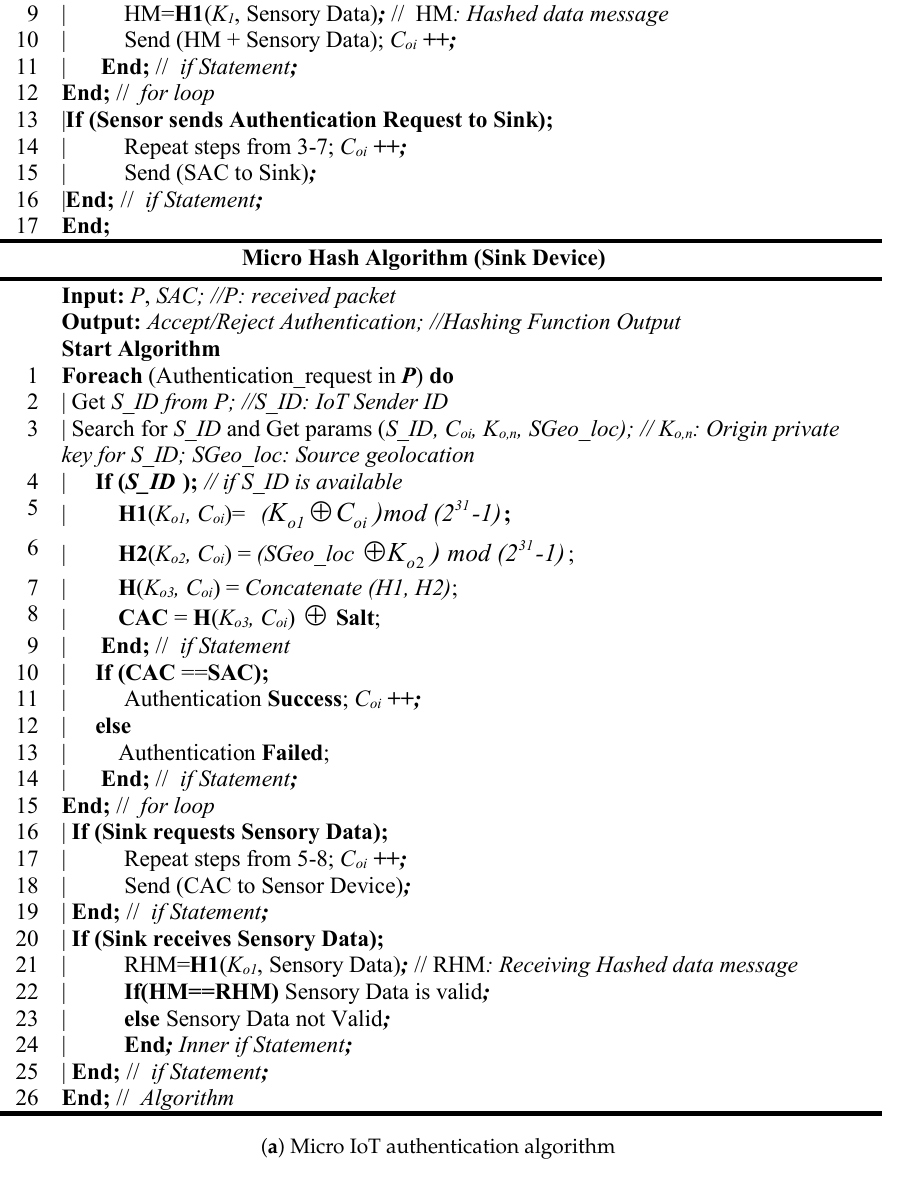
Figure 2. Cont. Figure 2.